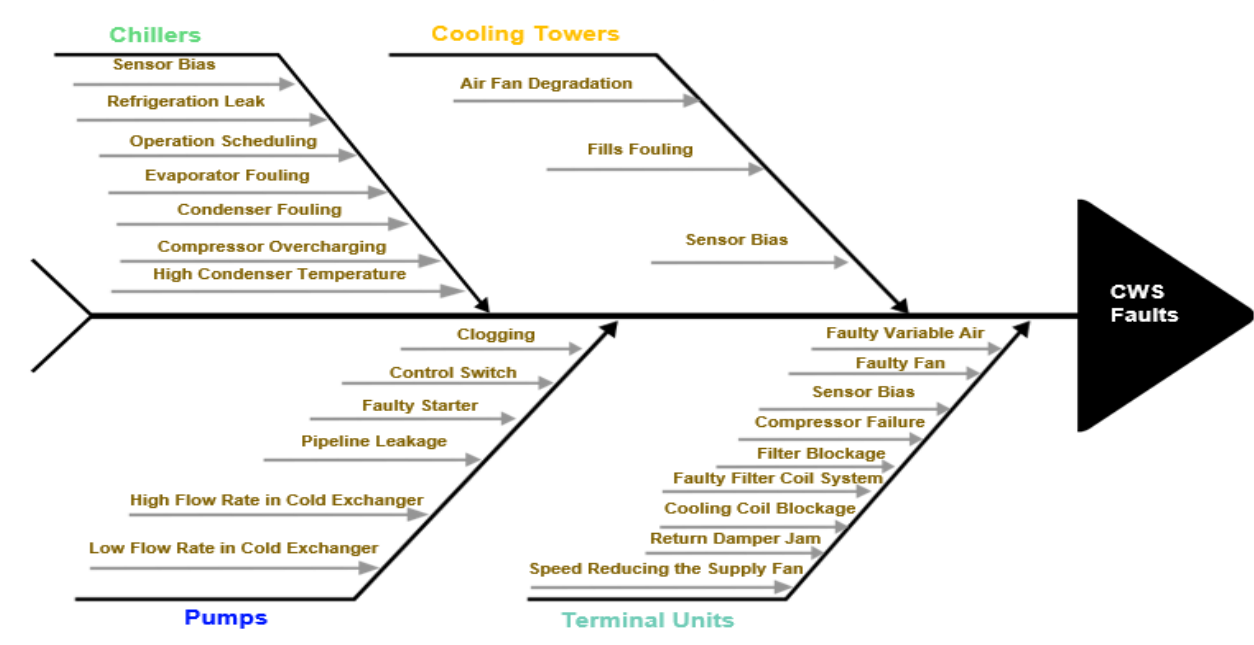
Figure 5. Monthly number of responses.